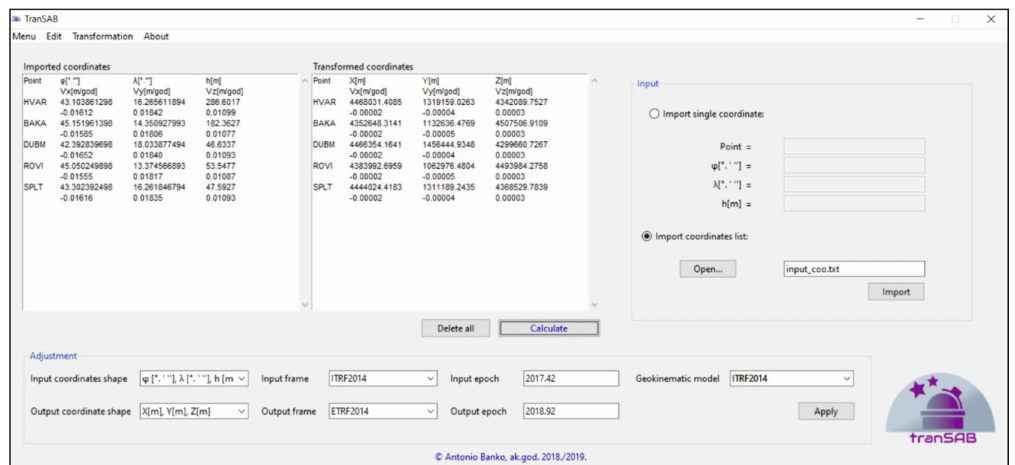
Figure 6. Computed coordinates (positions and velocities) based on the selected and entered parameters and imported